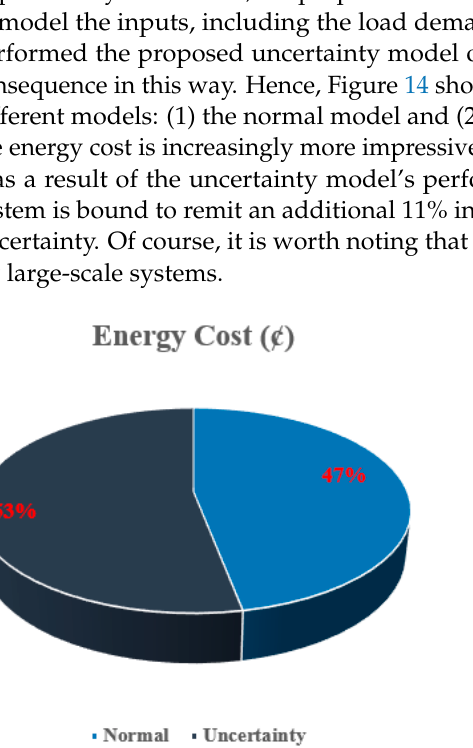
Figure 13. The vulnerability percentage for the physical and digital twins.